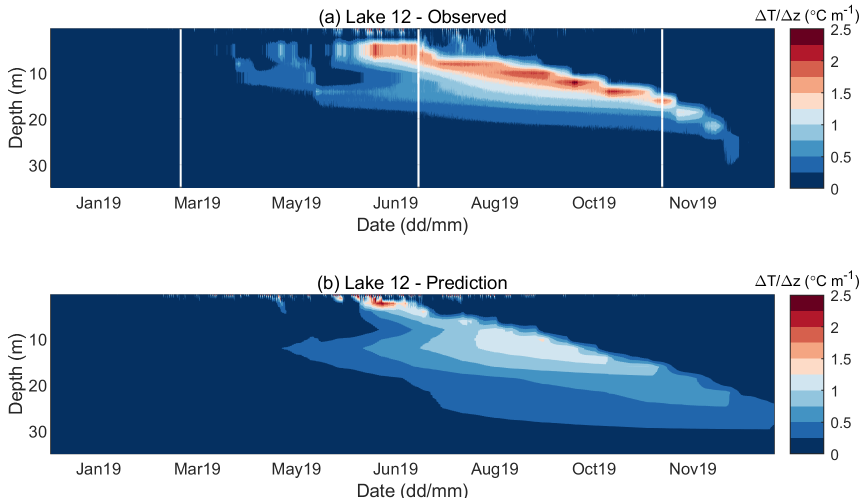
Figure 13. Observed (a) and predicted (b) water temperature gradient for Lake 12 in 2019. The predicted temperature gradient is obtained by a single yearlong simulation run initiated on 1 January